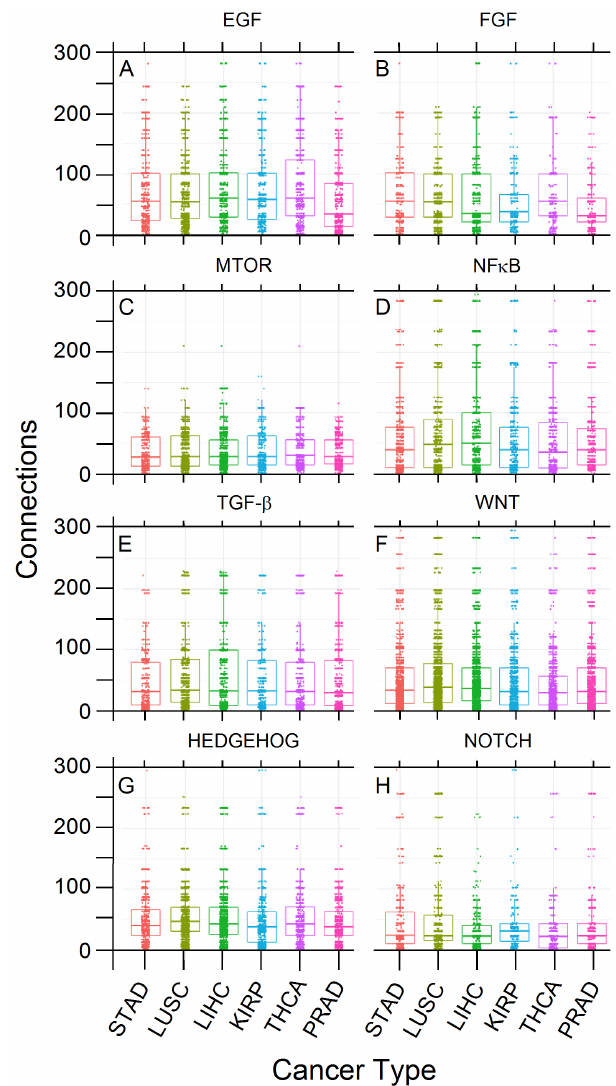
Figure 2. Frequencies (numbers) of upregulated genes’ connections per target pathway and cancer type. The plot is faceted per pathway and by Kruskal–Wallis p -values ( A ): 9.1 × 10 − 9 , ( B ): 1.9 × 10 − 4 , ( C ): 1.6 × 10 − 1 , ( D ): 4.9 × 10 − 8 , ( E ): 1.4 × 10 − 2 , ( F ): 2.9 × 10 − 10 , ( G ): 1.4 × 10 − 8 , ( H ): 1.1 × 10 − 8 . Each value indicates a group in which the average connection count is different from the global average within that